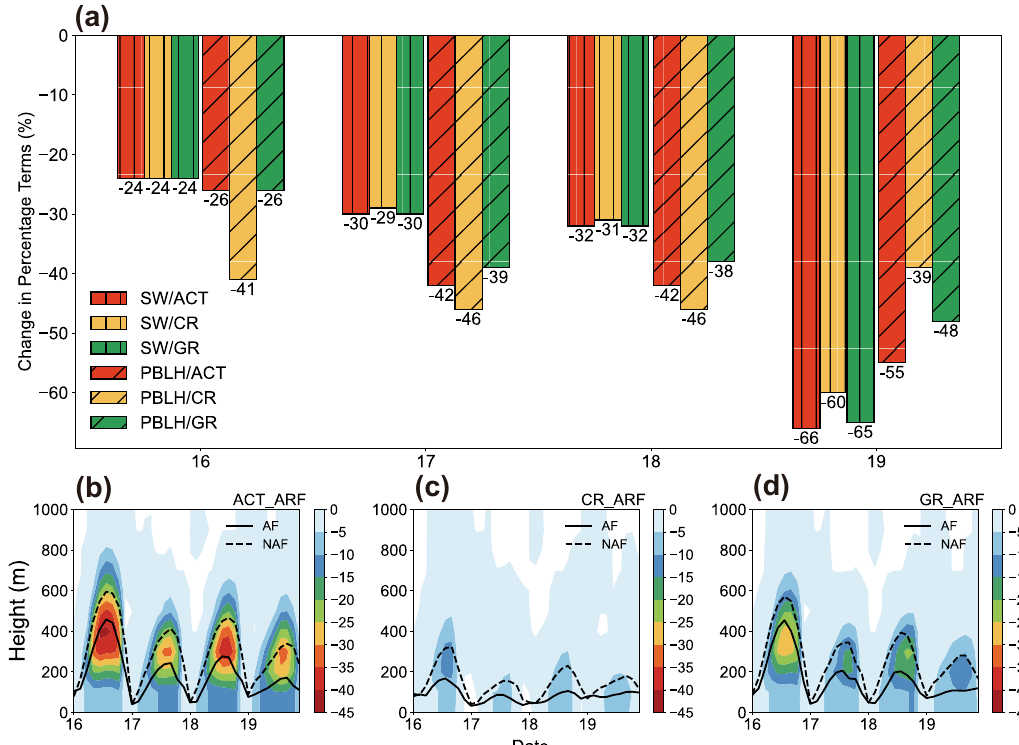
Fig. 4 Variation of aerosol – radiation – PBLH interaction on different pollution days. a Difference in daytime (9:00 – 17:00 LST) SW and PBLH in percentage terms ((AF-NAF)/NAF × 100%). Turbulent diffusivity coef fi cient of b ACT_ARF, c CR_ARF and d GR_ARF. The Black lines in b , c , and d represent